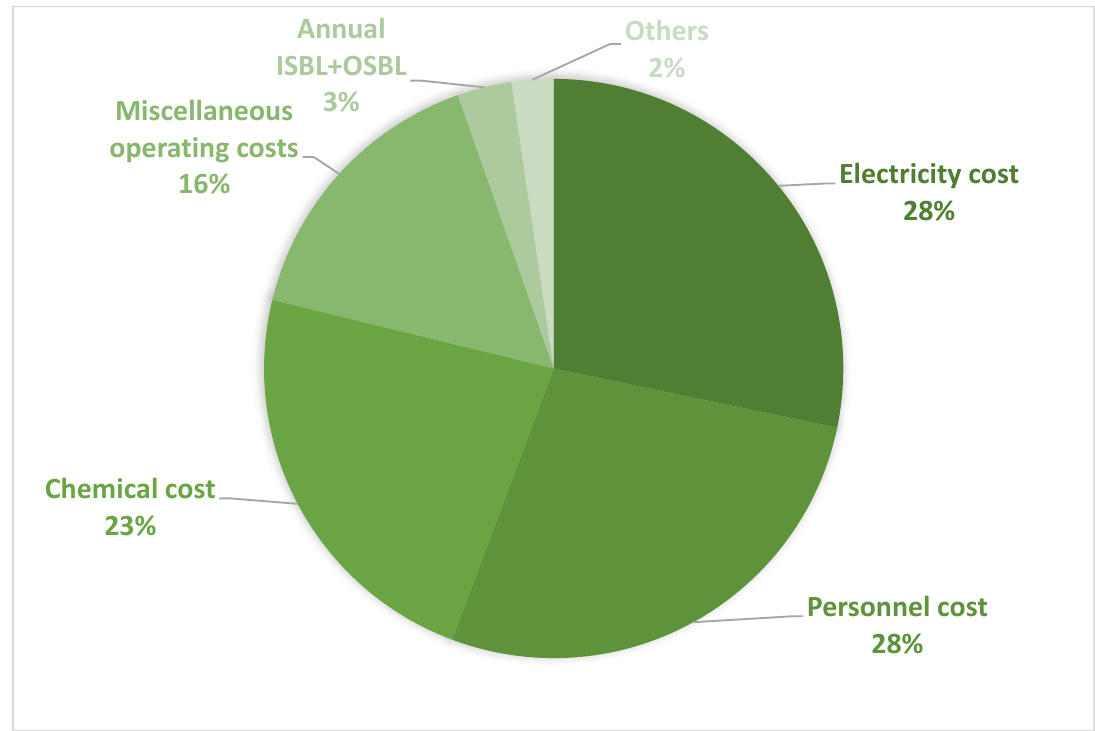
Figure 5. The various cost contributions towards the cost of production of recyclate plastics.